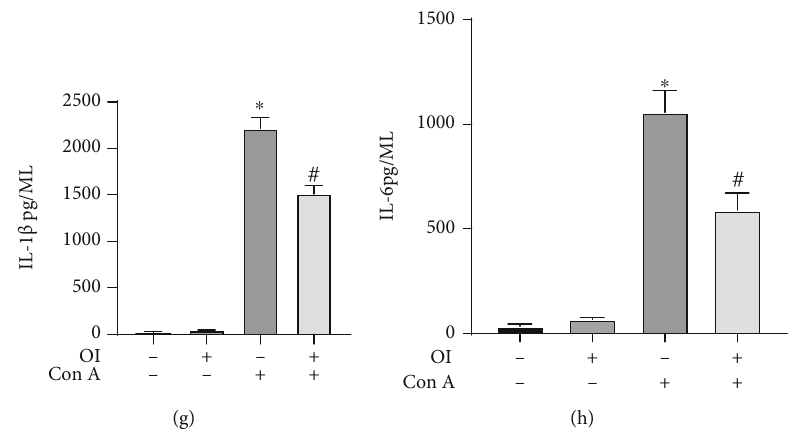
Figure 6: OI mitigated Con A-induced activation of NF-?B activation and expression of proin fl ammatory cytokines in macrophages. (a) OI administration reduced Con A-induced NF-?B p65 nuclear translocation by immuno fl uorescence in RAW264.7 cells. (b) Immunoblots of NF-?B p65, phosphate-p65 (p-p65), I κ B- α , and phosphate-I κ B- α (p-I κ B- α ) in RAW264.7 in each group. The relative expression of (c) p- p65/NF-?B p65 ratio and (d) p-I κ B- α /I κ B- α ratio was analyzed in each group. (e) Western blot showed the expression levels of Nrf2 and HO-1. The levels of cytokines including (f) TNF- α , (g) IL-1 β , and (h) IL-6 in supernatant were measured. GAPDH was used for endogenous control. White arrow showed positive nuclear translocation cells. All tests were independently performed three times. ∗ p < 0 : 05 vs. control group; # p < 0 : 05 vs. Con A group. Data are expressed as mean ± SEM